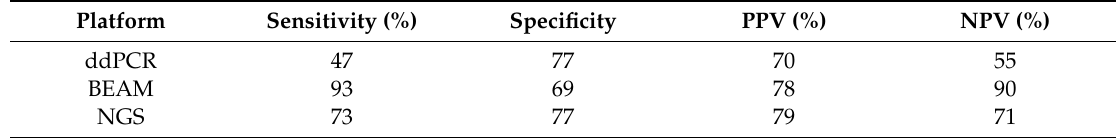
Table 1. Comparison of the sensitivity, specificity, PPV (positive predictive value), and NPV (negative predictive value) of ddPCR, BEAM, and NGS for KRAS detection